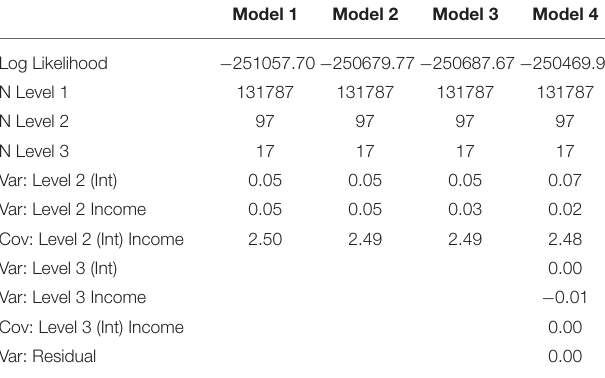
TABLE 3 | Hybrid multilevel regression models of individual support for